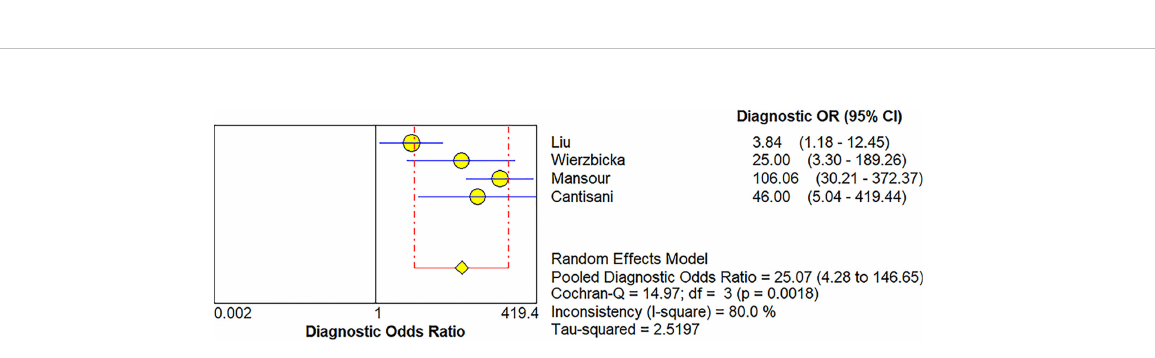
FIGURE 7 Forest plot for diagnostic odds ratio of conventional ultrasound for diagnosis of malignant salivary gland tumors.